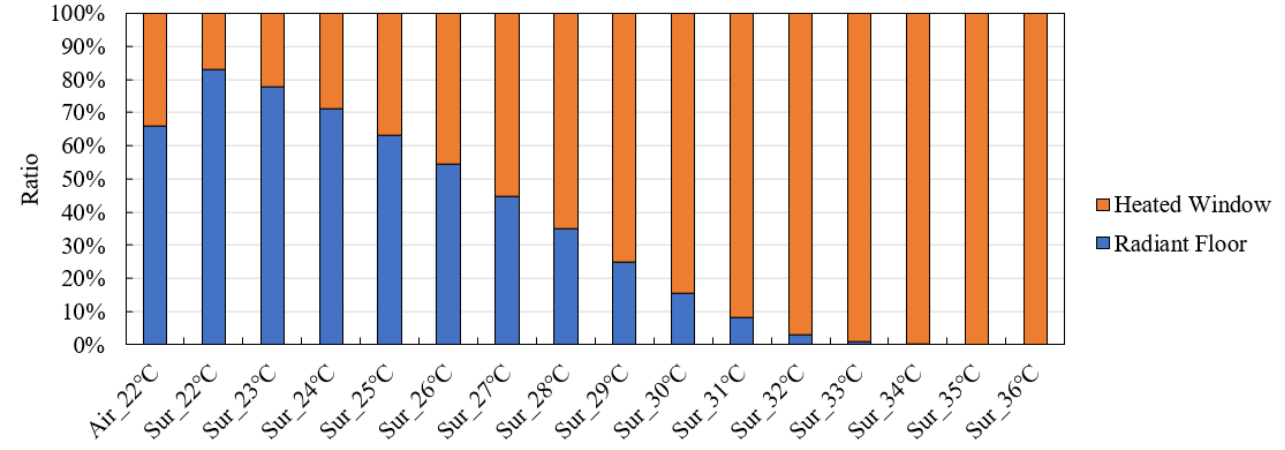
Figure 15. Ratio of heating load to annual heating load for each heating system.